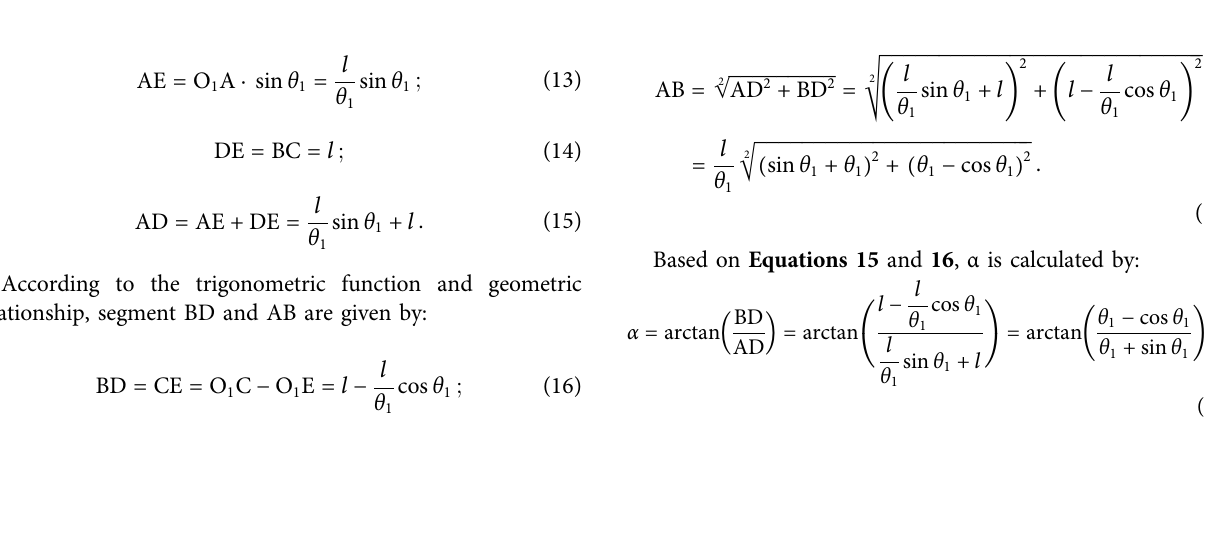
Frontiers in Materials |